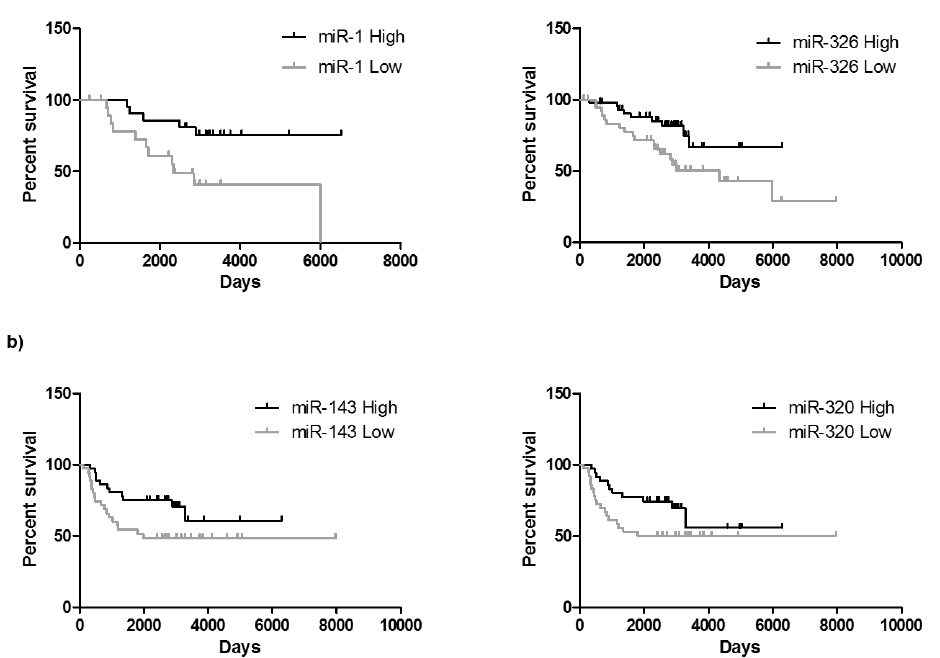
Figure 5. CRC progression indicated by miRNAs expression. Overall survival ( a ) and progression free survival ( b ) correlation studies have been performed by means of Kaplan Meier curves. Median value of each miRNA has been used to distribute high and low miRNA values. High expression of miR-1-3p and miR-326 are significantly associated with longer overall survival and higher expression of miR143-3p and miR-320a correlate with longer progression free survival.